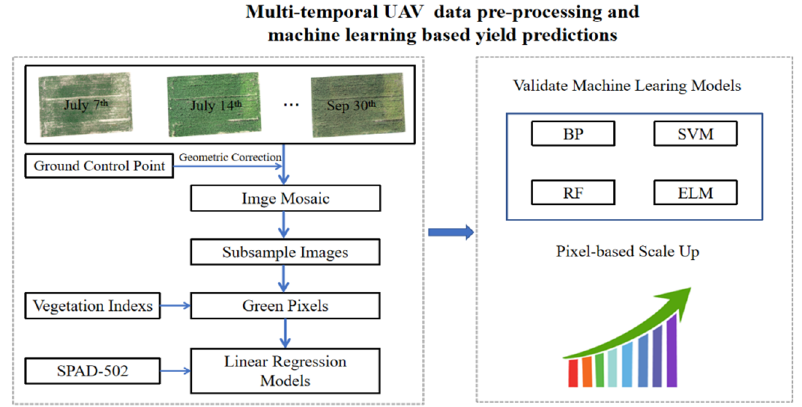
Figure 3. The flow diagram of ML-based yield predictions. The upper part is the multi-temporal images analysis, and the lower part is the ML-based yields predictions.